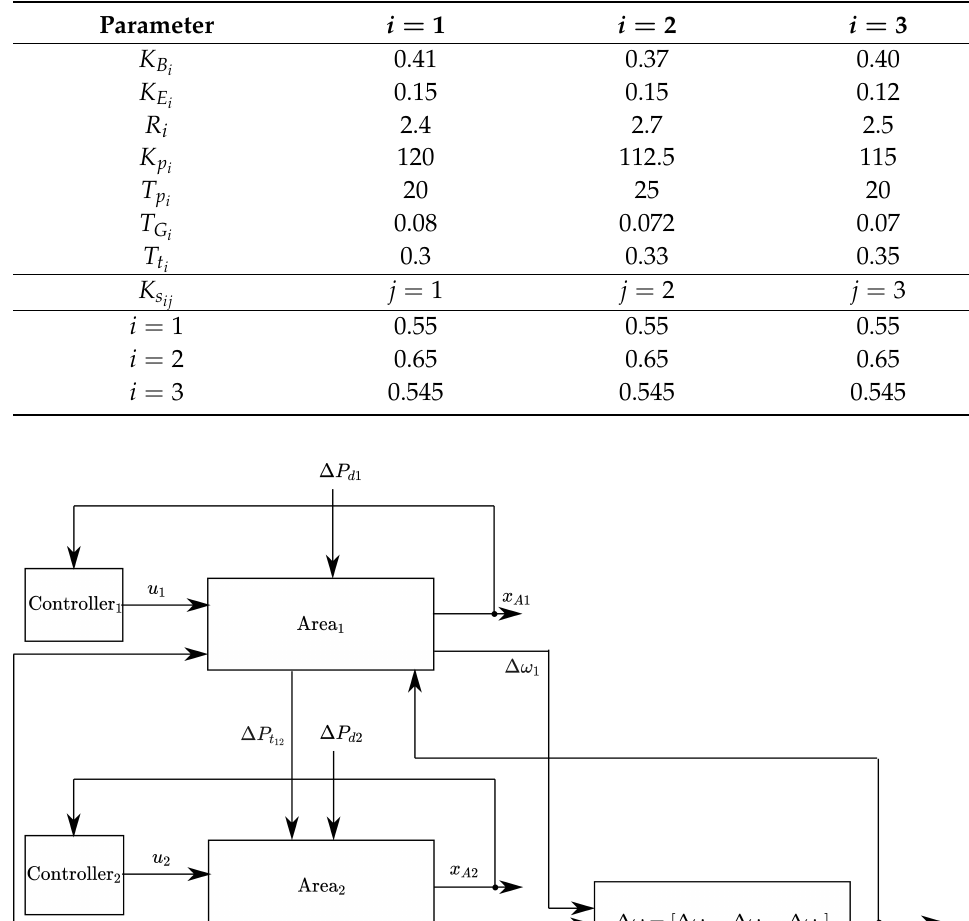
Table 1. Parameters of the 3-area model.